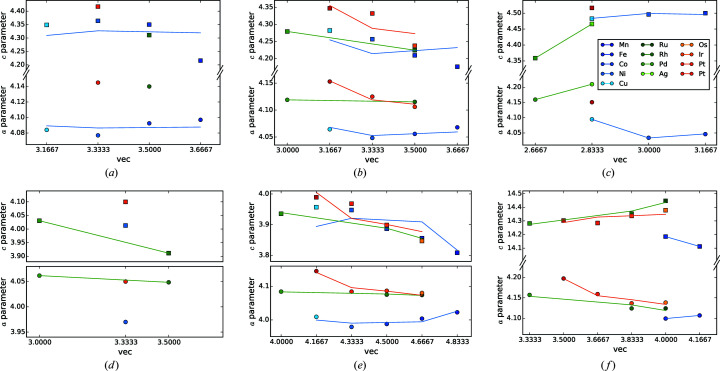
Influence of the valence electron concentration on the lattice parameters of R
2
TSi3 compounds, for a constant R element and at least five different T elements. (a) R = La, hexagonal , (b) R = Ce, hexagonal, (c) R = Eu, hexagonal, (d) R = Dy, hexagonal, (e) R = U, hexagonal and (f) R = Th, tetragonal.